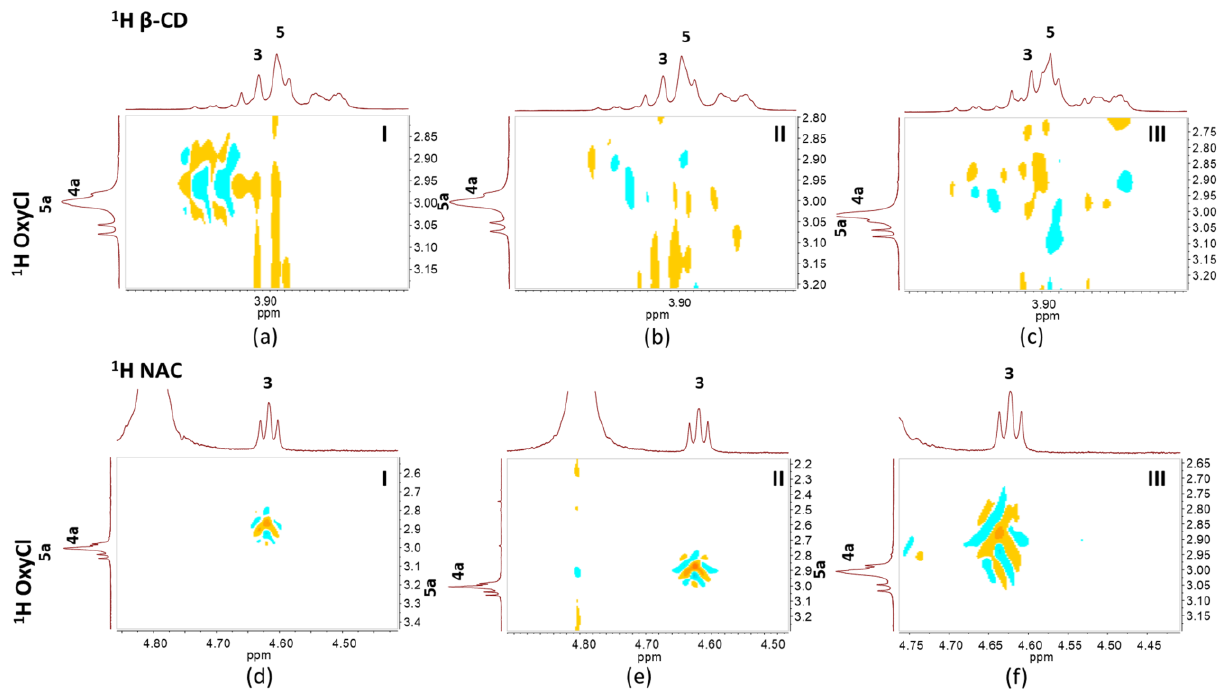
Figure 3. Partial contour plot of the 2D NOESY spectrum showing the intermolecular proximities of ( a ) OxyCl-I: β -CD, ( b ) OxyCl-II: β -CD, ( c ) OxyCl-III: β -CD, ( d ) OxyCl-I:NAC, ( e ) OxyCl-II:NAC, and ( f ) OxyCl-III:NAC.